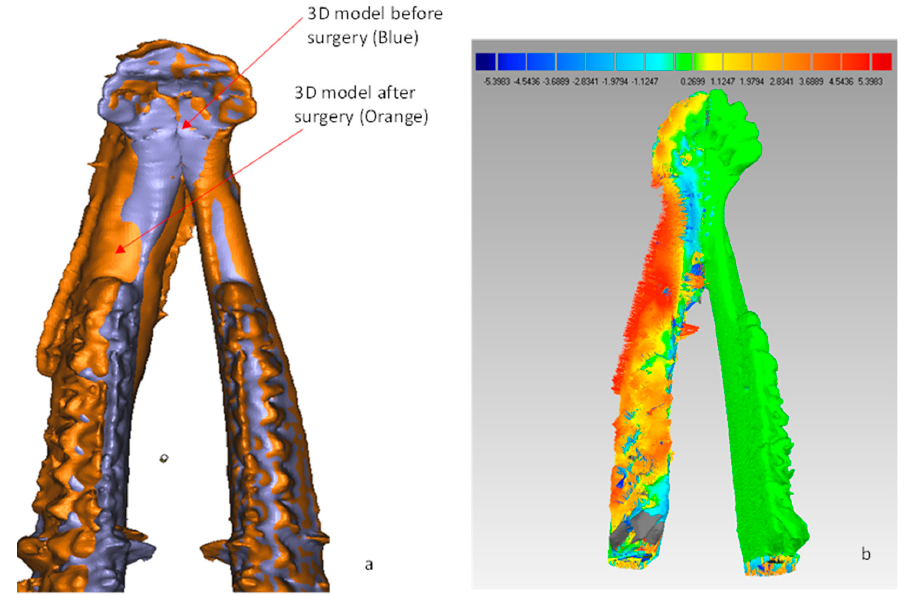
Figure 10. ( a ) The alignment of 3D models before and after surgery and ( b ) the computed surface deviation test results of a reconstruction mesh plate.